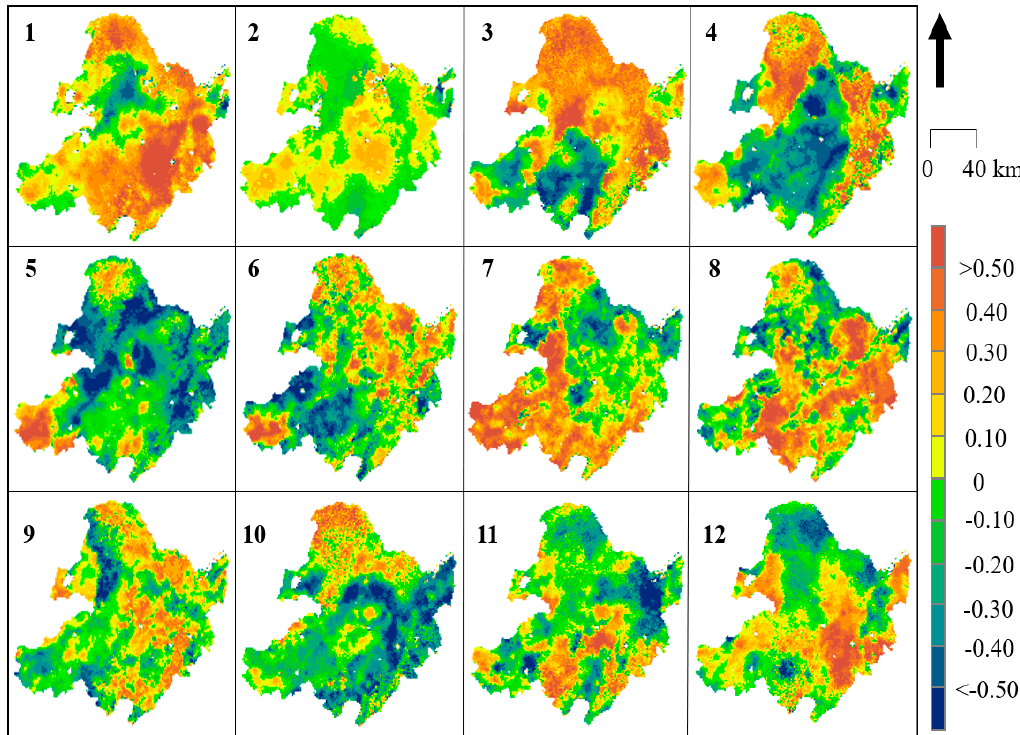
Sensors 2019 , 19 , x FOR PEER REVIEW Figure 8. Trends in R for the mean monthly downscaled daytime SM from 2002 to 2018 in NEC.